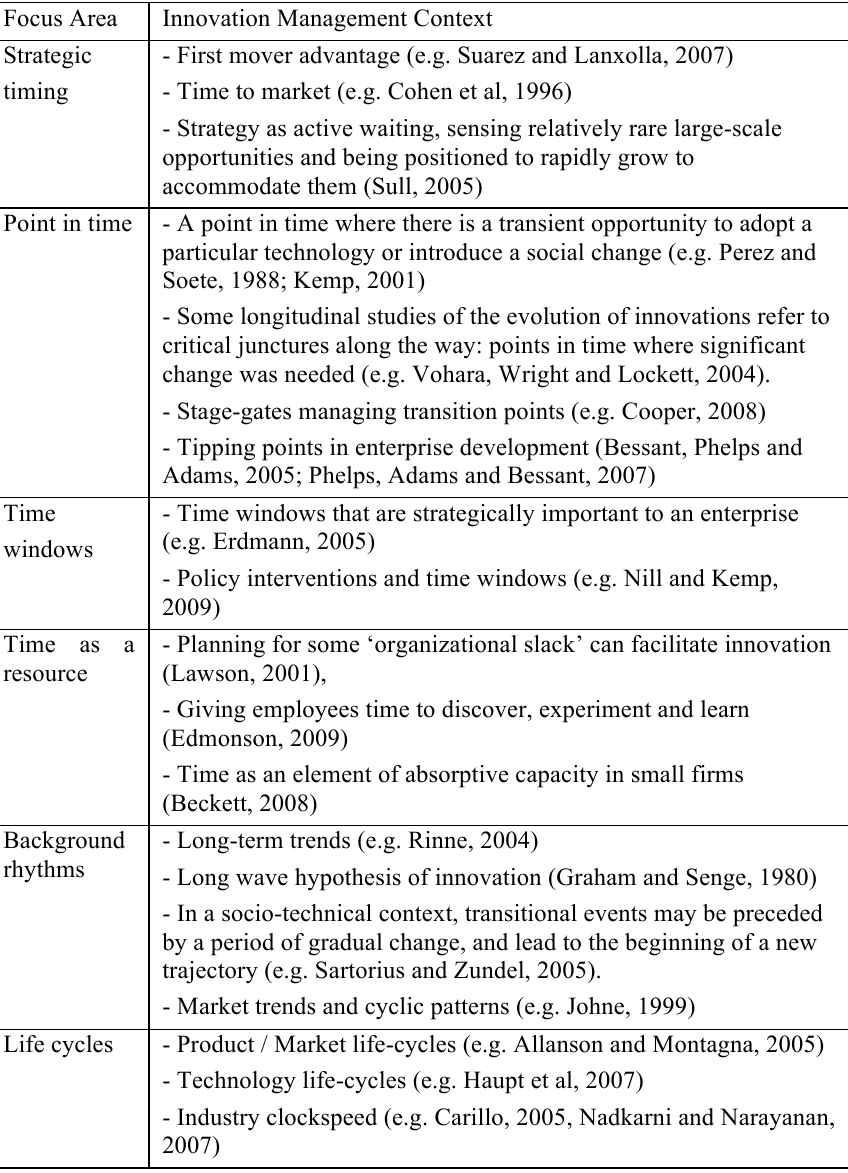
Table 1. Some observations about time and timing from the literature Focus